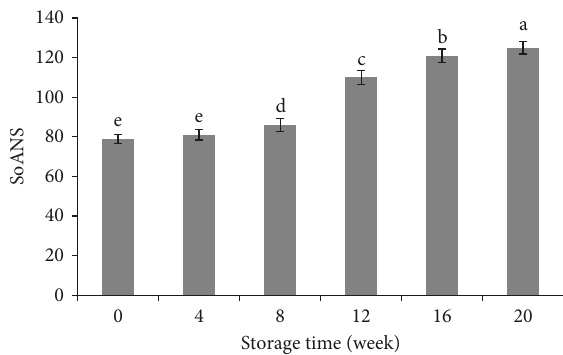
Figure 3: Changes in surface hydrophobic content of NAM extracted from the Basa fish fillet during frozen storage at − 20 ° C for 20 weeks. Bars represent standard deviation from triplicate de- terminations. The different letters on the bars indicate significant differences ( p < 0 . 05).